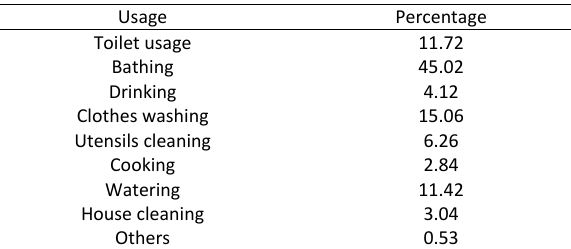
Table 7: Different water usage